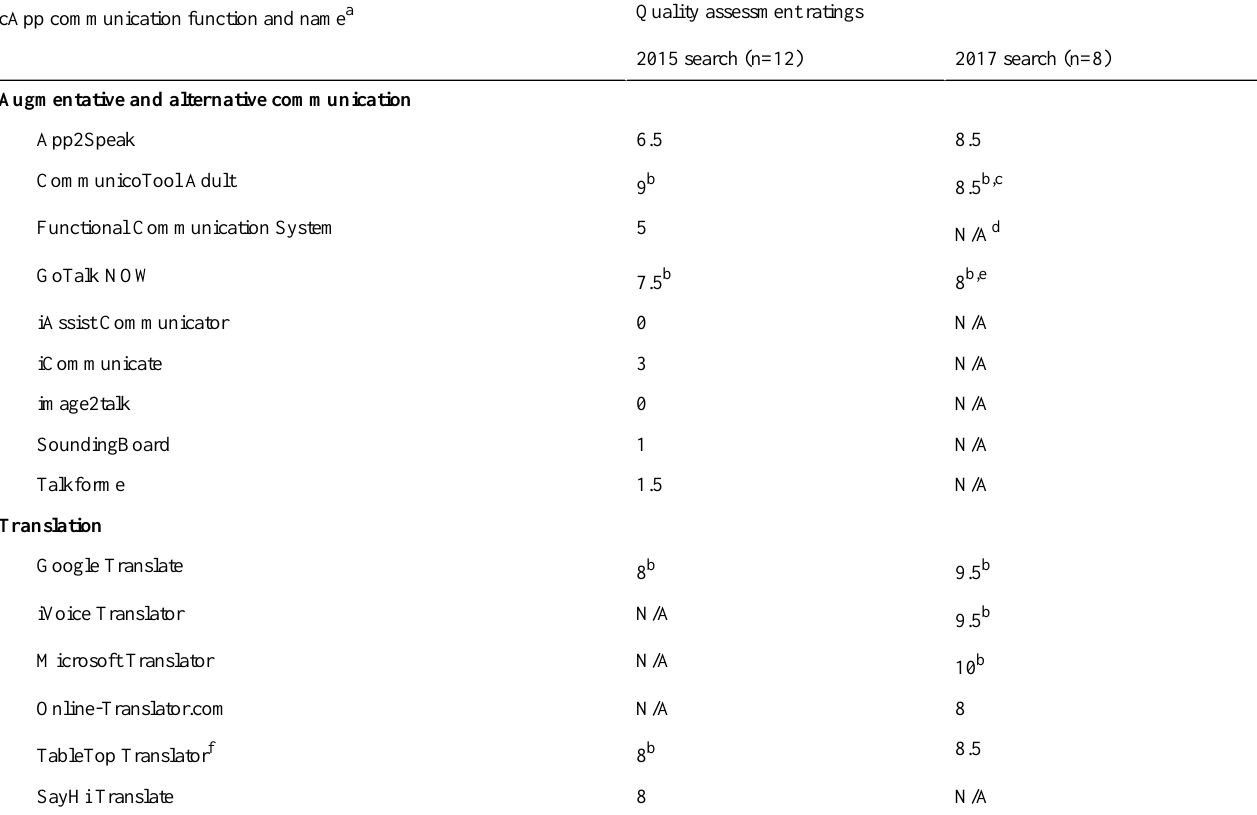
Table 7. Communication apps downloaded for final quality assessment ratings (the final quality assessment rating is based on the median rating of 2 reviewers. The maximum total rating score for cApps apps was